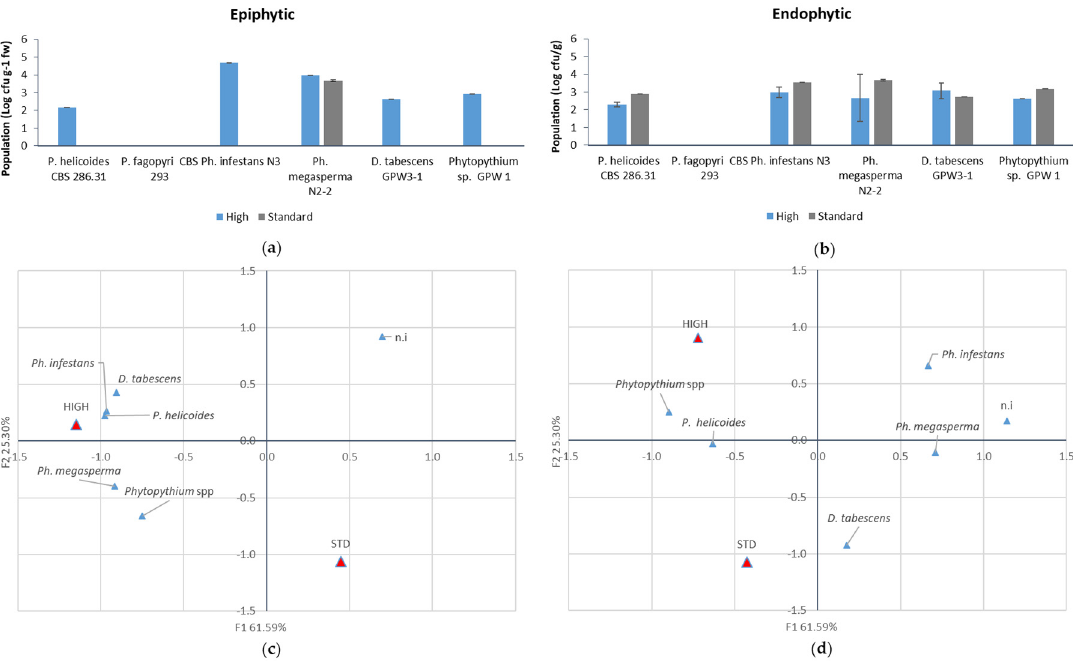
Figure 7. Epiphytic ( a ) and endophytic populations ( b ) of fungal pathogen expressed as Log (cfu g − 1 plant fresh weight), in high irrigation (HIGH) input or standard strategies (STD) after experimental inoculation. Two-dimensional principal component analysis (PCA) describing the distribution of samples based on water input (HIGH or STD) and the re-isolated populations on the surface ( c ) or inside ( d ) kiwifruit